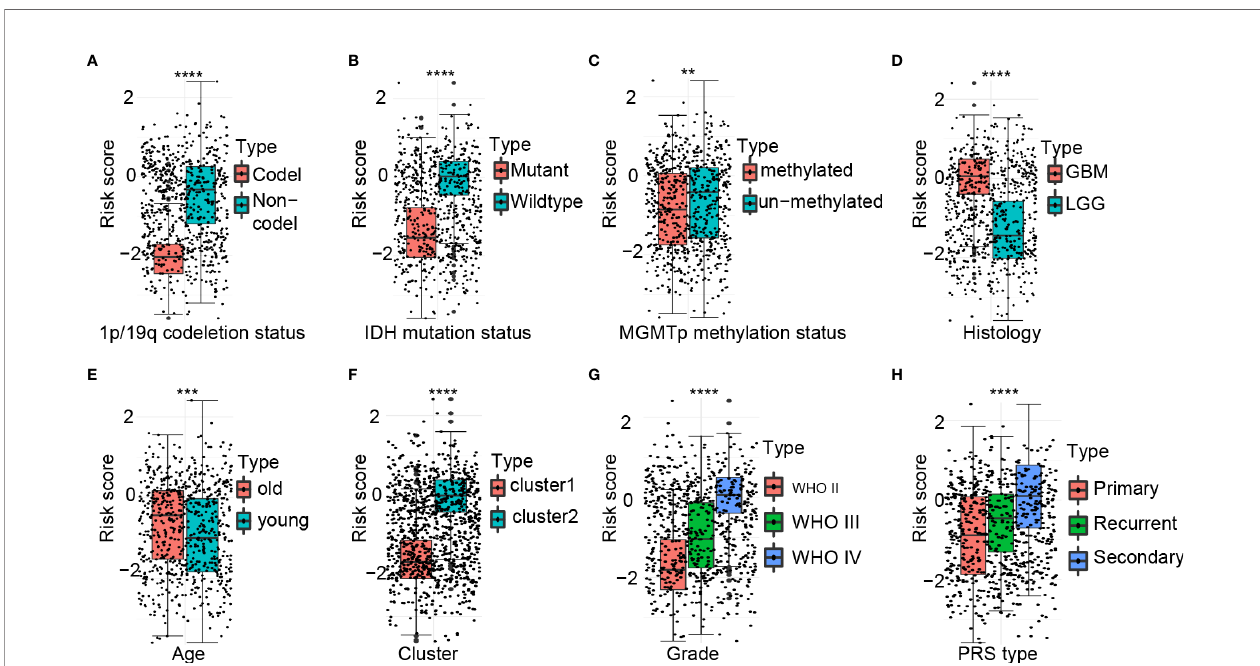
FIGURE 3 | Association between the ferroptosis-related signature and other pathological features in CGGA cohort. (A – H) Distribution of the risk score in patients strati fi ed by 1p/19q status (A) , IDH status (B) , MGMT promoter methylation (C) , Histology (D) , Age (E) , Cluster (F) , WHO grade (G) , and PRS type (H) . **** P < 0.0001; *** P < 0.001; ** P <